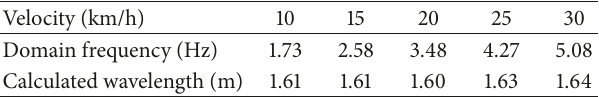
Table 1: Calculated wavelength of